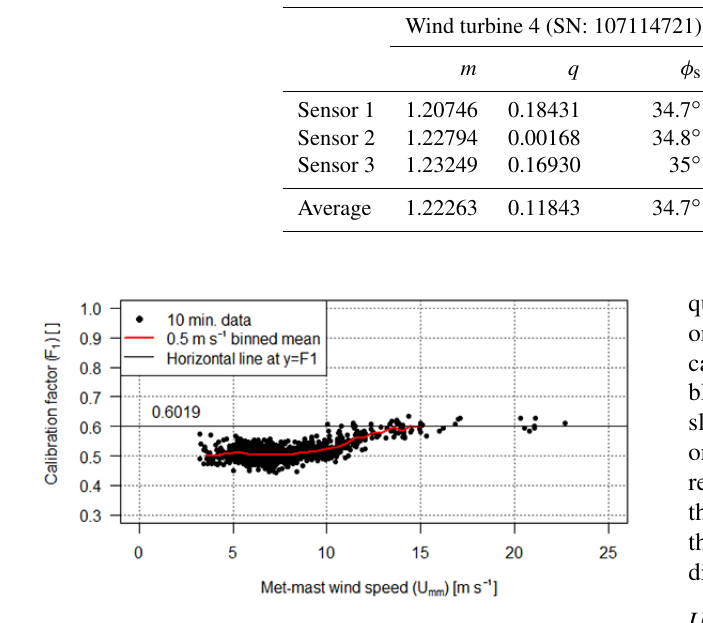
Figure 4. Calibration factor F 1 as a function of free wind speed during operation of the wind